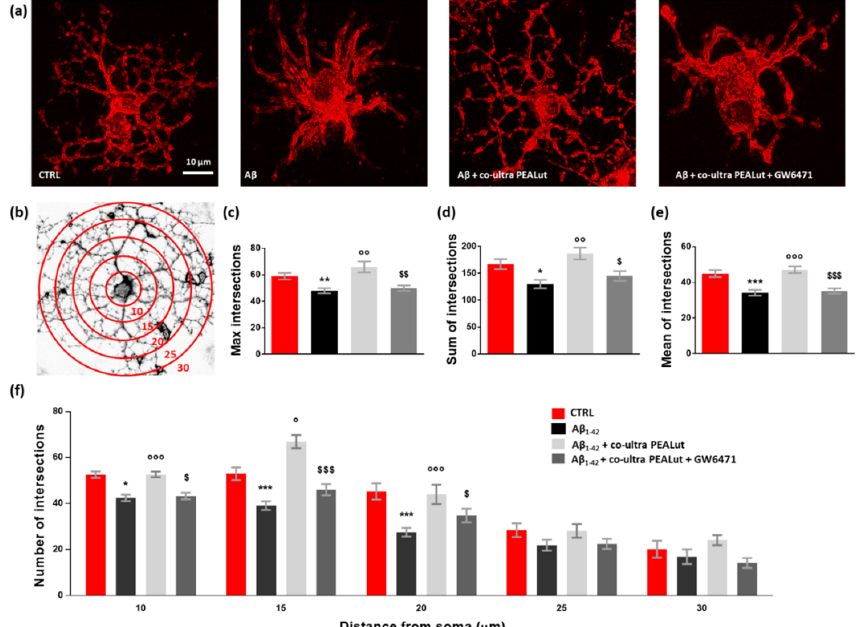
Figure 6. Co-ultra PEALut limits the A β 1–42 -induced alterations in oligodendrocyte morphology. ( a ) Representative photomicrographs of MBP + cells taken using a 40 × objective mounted on a fluorescent microscope. Scale bar is 10 µ m. ( b ) Eight-bit image of a representative MBP + cell, used in the Sholl analysis, in which concentric circles were juxtaposed on each MBP + cell starting from 10 μ m far from the cell soma and spaced 5 μ m apart. ( c ) Maximum number of intersections, that is the highest number of processes/branches counted in each MBP + cell. ( d ) Sum of intersections, that is the number of intersections counted in each circle. ( e ) Mean of intersections, that is the ratio sum of intersections /number of circles. ( f ) Number of intersections counted every 5 μ m starting from 10 μ m far from the cell soma until 30 μ m. At least 20 cells per animal were counted. Data are plotted as mean ± SEM. * p < 0.05; ** p < 0.01; *** p < 0.001 vs. CTRL; ° p < 0.05; °° p < 0.01; °°° p < 0.001 vs. A β 1-42 ; $ p < 0.05; $$ p < 0.01; $$$ p < 0.001 vs. A β 1-42 + co-ultra PEALut (SNK).